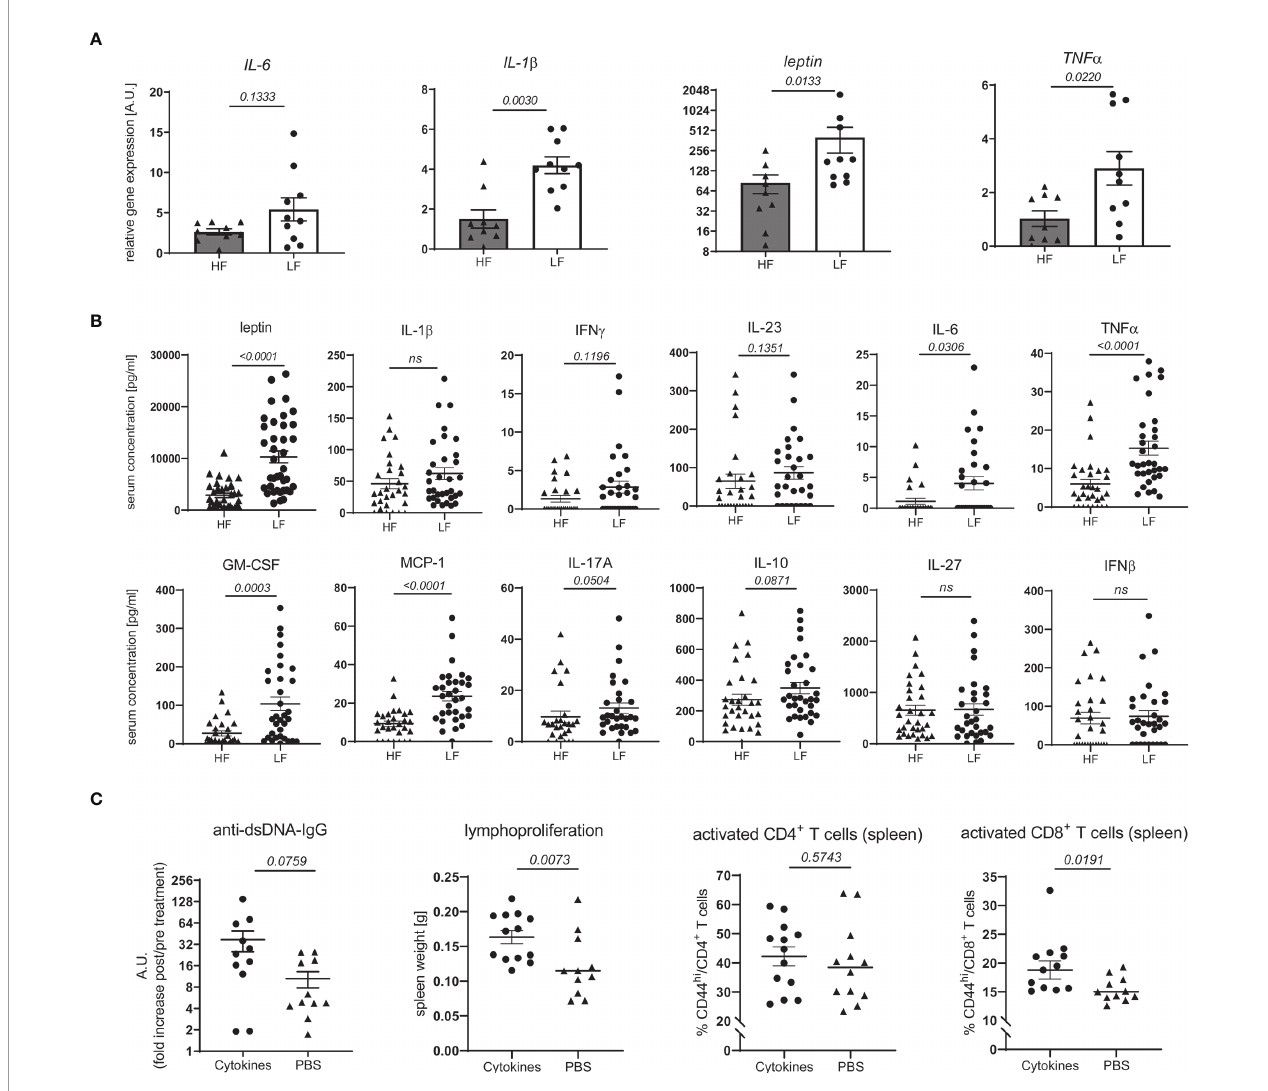
FIGURE 4 | Link between dietary fi ber, WAT and systemic in fl ammation and lupus pathology. Lupus-prone NZB/WF1 mice were fed a HF- or LF-diet. (A) Relative mRNA expression of IL-1 b , IL-6, TNF a and leptin was examined in gonadal WAT of 28 w old animals (n HF = 9 mice, n LF = 10 mice). (B) Serum concentrations of leptin and a panel of cytokines in 28 w old animals were determined by Plex assays (n HF = 26 – 35 mice, n LF = 30 – 38 mice). (C) 20 w old NZB/WF1 mice were treated over a period of 6 weeks with a mix of recombinant TNF a , IL-6 and IL-1 b or PBS; determined was the increase in anti-dsDNA-IgG post- compared to pre-treatment as well as development of lymphoproliferation (spleen weight) and expression of CD44 on CD4 + and CD8 + T cells post-treatment (n cytokines = 11 – 13; n PBS = 11 – 12). Results are expressed as scatter blots with mean ± SEM; each data point represents an individual mouse; p < 0.05 was considered signi fi cant, p > 0.2 is indicated as ns, not signi fi cant